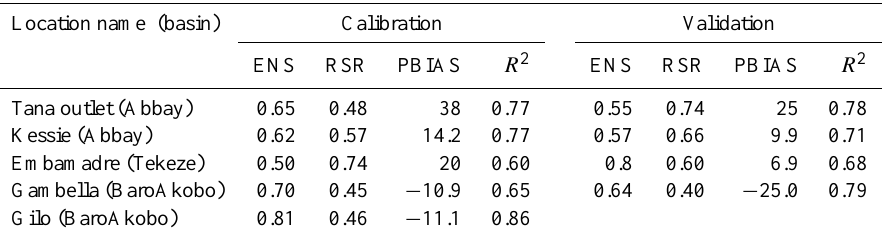
Fig. 7. Monthly observed (blue) and simulated (black) streamflow for the calibration and validation periods at (a) Diem (Abbay), (b) Gambella (Baro Akobo) and (c) Embamadre (Tekeze). Table 6. Summary of daily streamflow statistics for the calibration and validation simulations for the Eastern Nile subbasins: ENS: Nash- Sutcliffe efficiency, PBIAS: mean relative bias, RSR: root mean square error-standard deviation ratio and R 2 : coefficient of determination (see Table 5 for details).Dates for calibration and validation period is given in Table